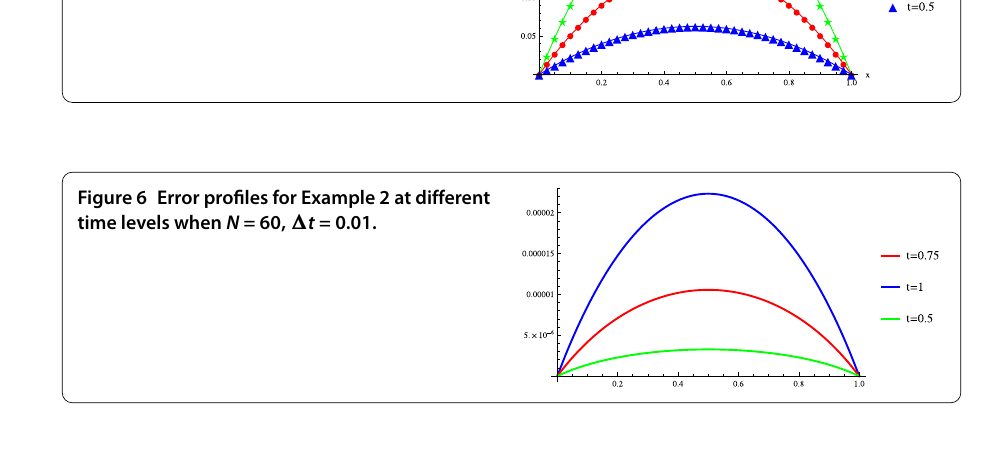
Figure 5 The comparison of exact (lines) and approximate solutions for Example 2 when